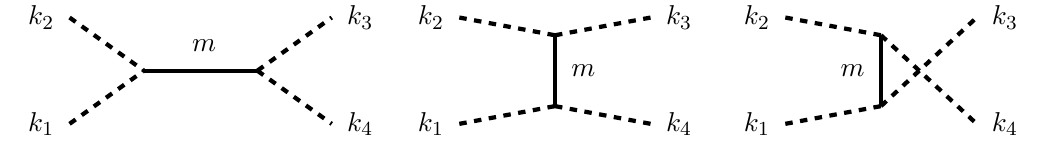
Figure 1 . Four-Point Exchange